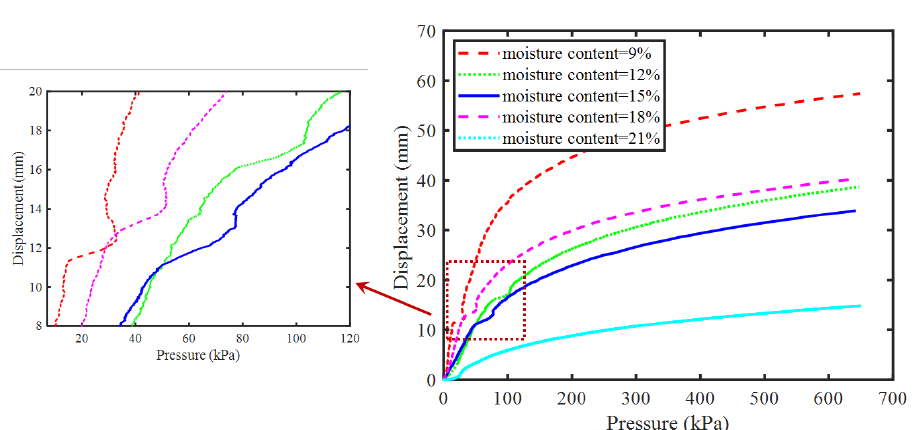
Figure 7. Pressure−displacement curves of tailings specimens with different moisture under con- Figure 7. Pressure − displacement curves of tailings specimens with different moisture under continuous tinuous load.